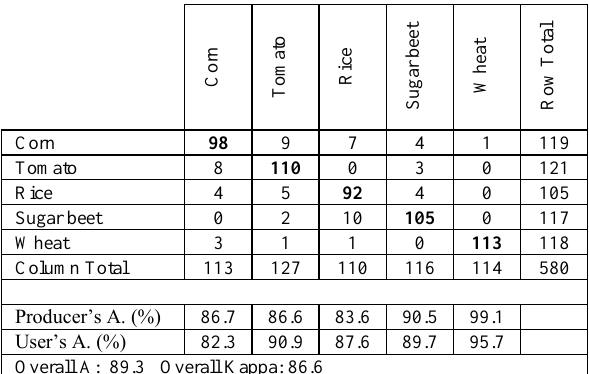
Table 3 Error matrix of pixel-based